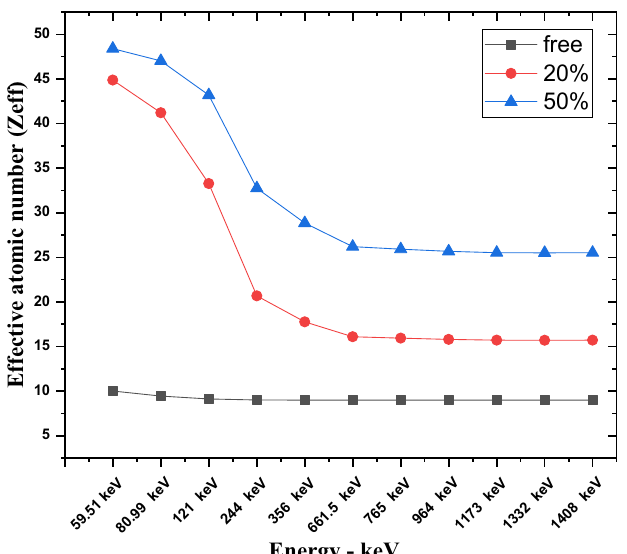
Figure 5. The equivalent atomic number of free silicon rubber, 20% SnO 2 /SR, and 50% SnO 2 /SR for different gamma ray